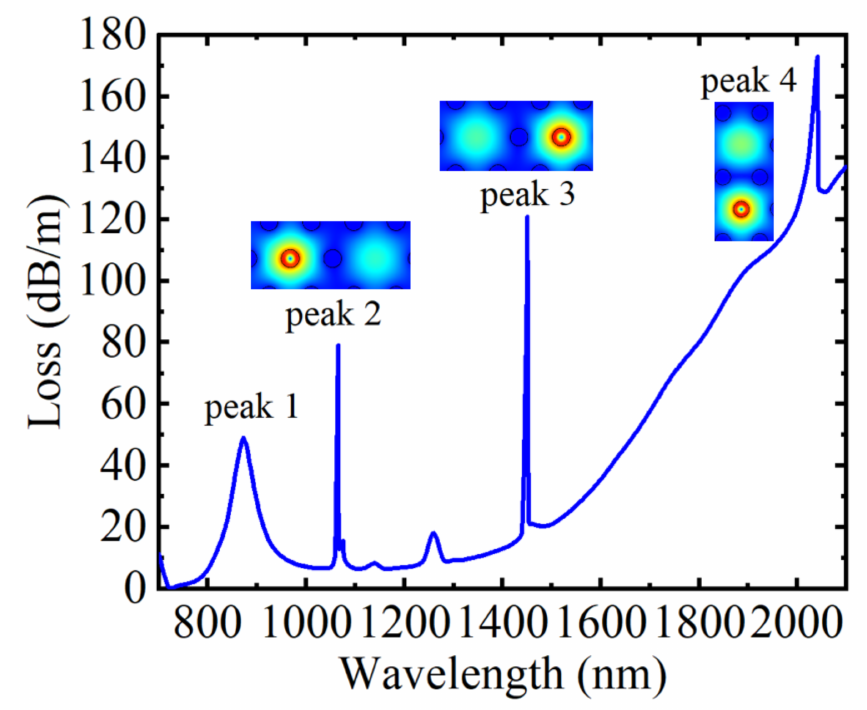
Figure 2. The loss spectrum of the core guide mode of the D-shaped PCF when n = 1.41, H = 250 Oe, T = 20 ◦ C, and V = 30 V, the insets are the mode field distribution of peak 2, peak 3, and peak 4, respectively.